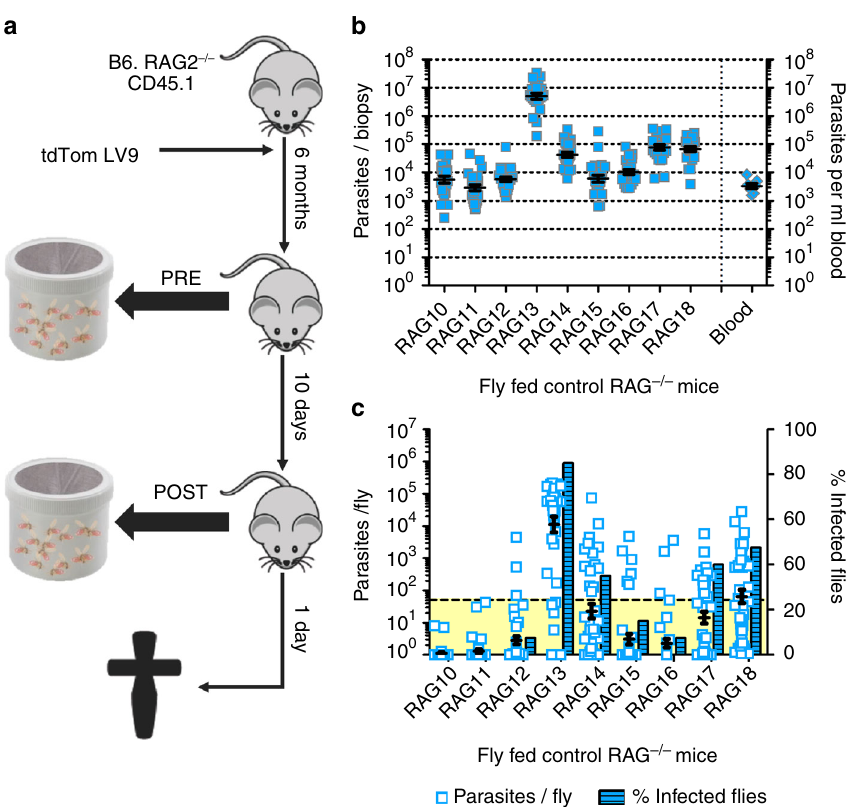
Fig. 2 Analyzing impact of skin parasite burden on outward transmission. a Schematic representation of the experimental sand fl y exposure procedure. b Scatter plot of parasite loads in skin for each mouse (ø 0.8cm; vol. 12mm 3 ; technical repeats N = 24 biopsies per mouse; total N = 216) and blood parasitemia (per ml; biological replicates N = 9) of each mouse. Mean and standard error bars are shown. Skin parasite load variability per mouse was analyzed by two-tailed one-sample t -test ( P < 0.001 each), data variance between all mice (biological replicates N = 9) within the group by Brown-Forsythe test ( P < 0.001) and mean biopsy parasite load by one-way Kruskal-Wallis test ( P < 0.001). c Experimental qPCR data of parasite loads per sand fl y after the second mouse exposure (scatter plot; technical replicates N = 40 per mouse, total N = 360) paired with the ratio (%) of sand fl ies harbouring > 50 parasites (threshold area in yellow ) at day 7 PBM (bar chart). Mean and standard error bars are shown (Scatter plot only). Sand fl y parasite load variability between sand fl ies fed on the same mouse were analyzed by two-tailed one-sample Wilcoxon signed-rank test ( P < 0.001 each), sand fl y data variance between Fly Fed control mice (biological replicates N = 9) by Brown-Forsythe test ( P < 0.001) and mean sand fl y parasite burden by one-way Kruskal-Wallis test ( P <